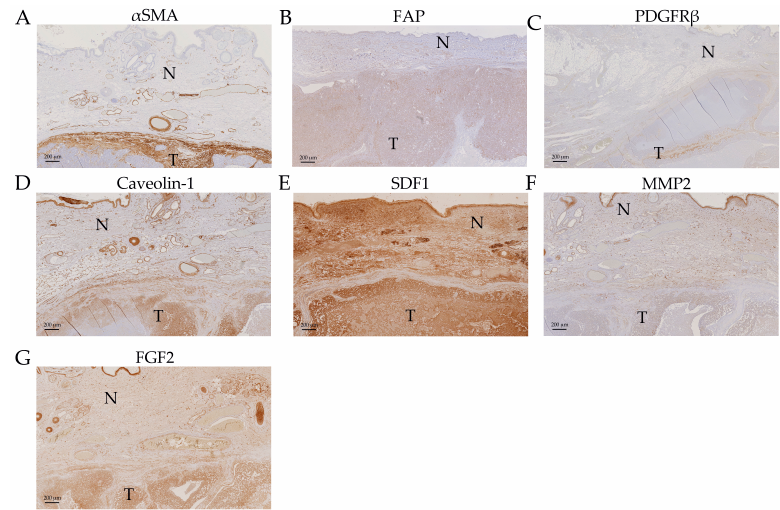
Figure 4. Immunohistochemical staining of a canine simple mammary carcinoma sample. Images are from Case #6), except for FAP, for which the image was taken from case #5. Pictures were taken at ×2 (for PDGFR β ) and ×5 (for the other gene products) magnification. T = tumour stroma, N = normal stroma. ( A ): α SMA; ( B ): FAP; ( C ): PDGFR β ; ( D ): Caveolin-1; ( E ): SDF1; ( F ): MMP2; and ( G ): FGF2. Int. J. Mol. Sci. 2017 , 18 , 1101